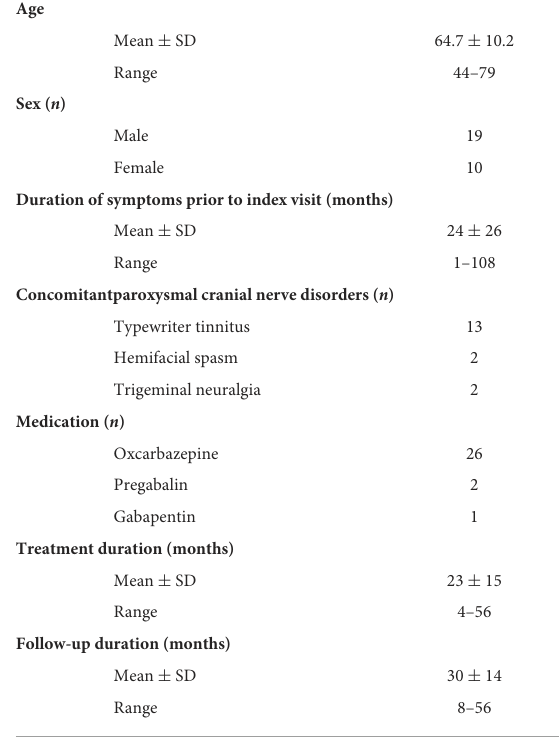
TABLE 2 Summary of the study cohort ( N =